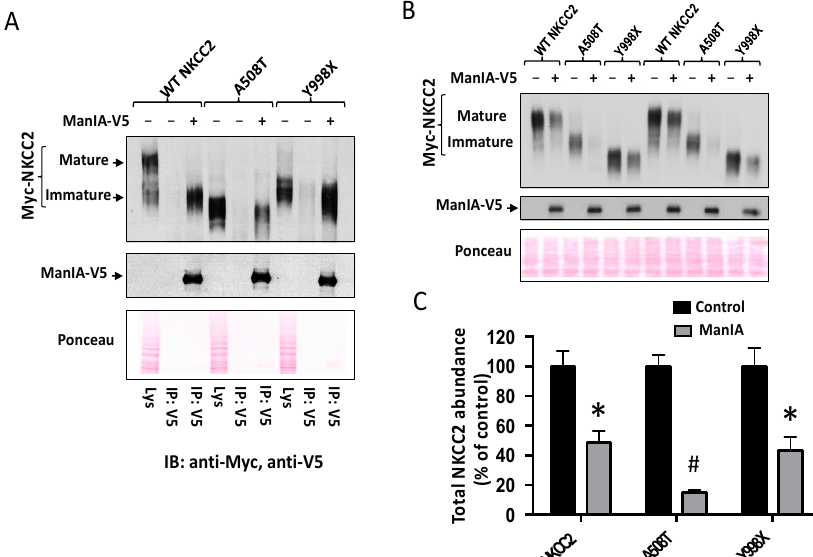
Figure 10. ManIA promotes the degradation of NKCC2 disease-causing mutants. ( A ) ManIA interaction with disease-causing mutants A508T and Y998X. HEK Cells were transiently transfected with Myc-NKCC2 or BS1 mutants (A508T or Y998X) either singly or in combination with WT ManIA-V5, as indicated. Cell lysates were immunoprecipitated (IP) with anti-V5 antibody. NKCC2 and ManIA proteins were detected by immunoblotting using anti-Myc and anti-V5 antibodies ( B ) ManIA effect on NKCC2 disease-causing mutants A508T and Y998X. HEK cells were transiently transfected with NKCC2 or BS1 mutants (A508T or Y998X) in the presence or absence of ManIA, as indicated. NKCC2 and ManIA proteins were detected by immunoblotting with Myc antibody and anti-V5. ( C ) Densitometric analysis of total NKCC2 proteins. *. Data are expressed as percentage of control ± S.E. *, p < 0.0007, #, p < 0.0001 ( n = 4) versus